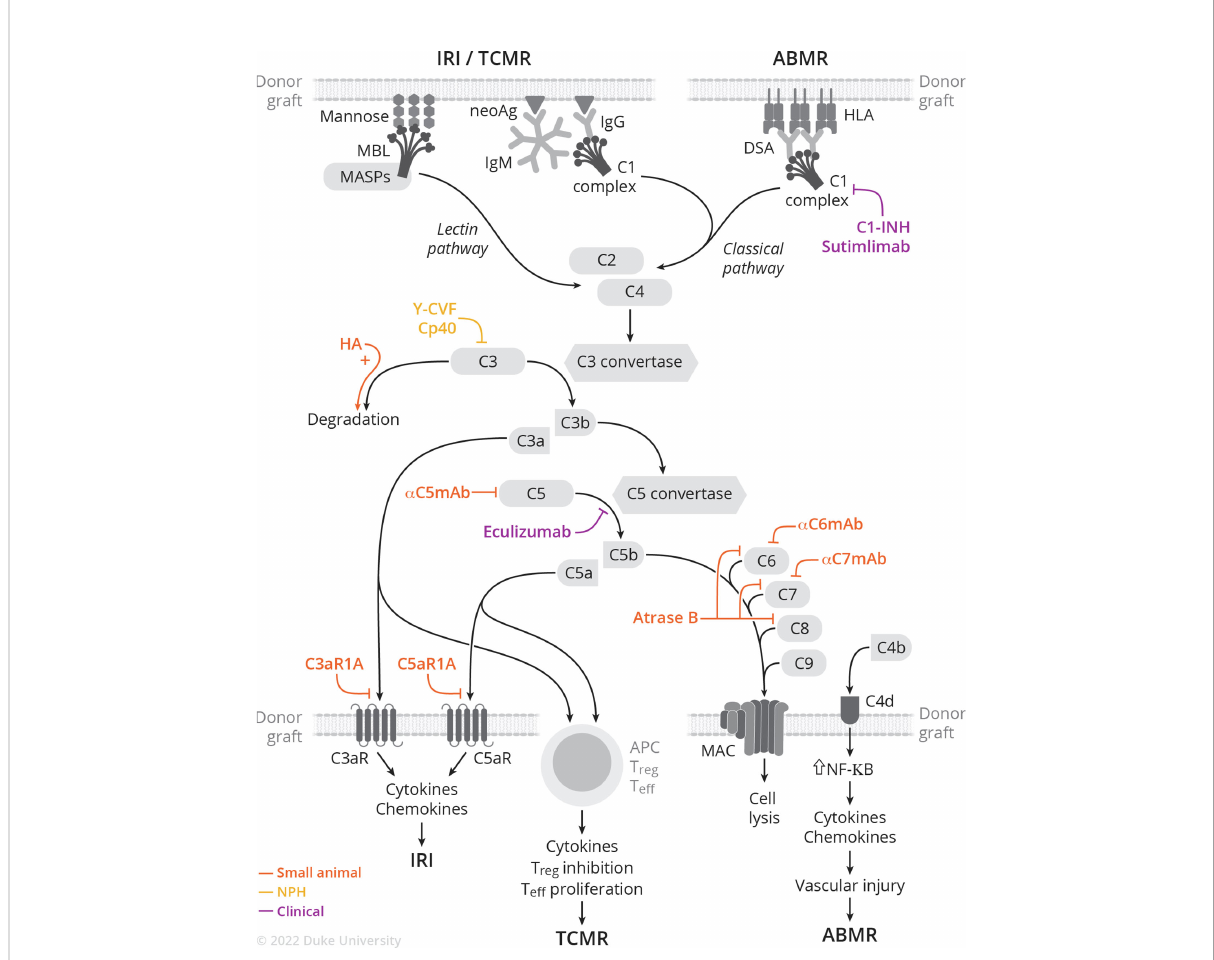
FIGURE 1 Complement activation cascade and complement-targeting therapies in small animal, NHP, and clinical studies of IRI, TCMR, and